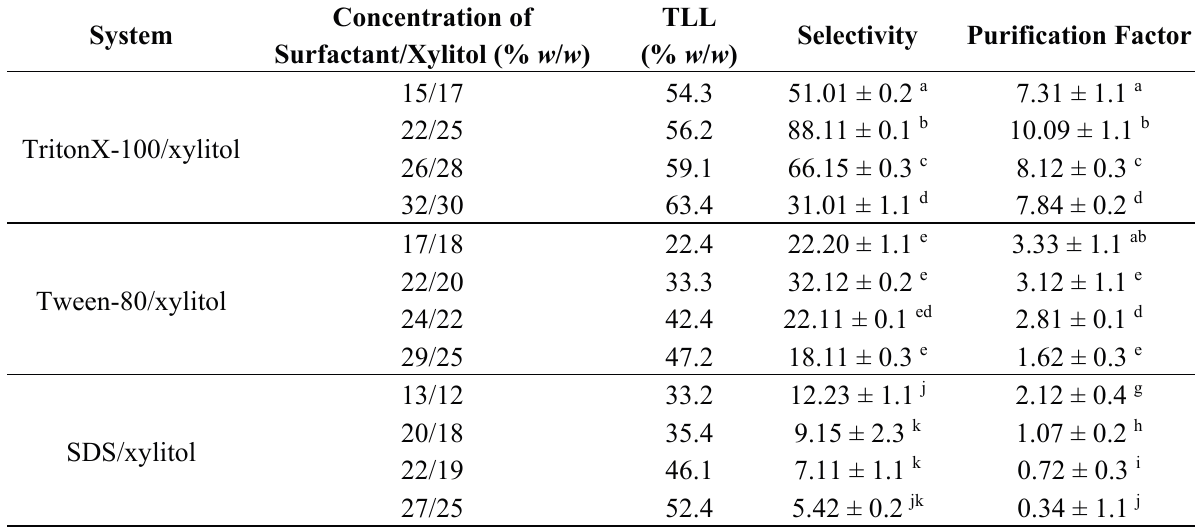
Table 2. Partition behavior of lipase in different surfactant/xylitol systems.